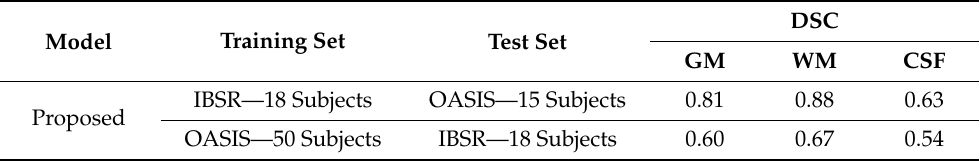
Table 9. Segmentation performance for brain MRI applying the proposed model trained on one dataset to the other